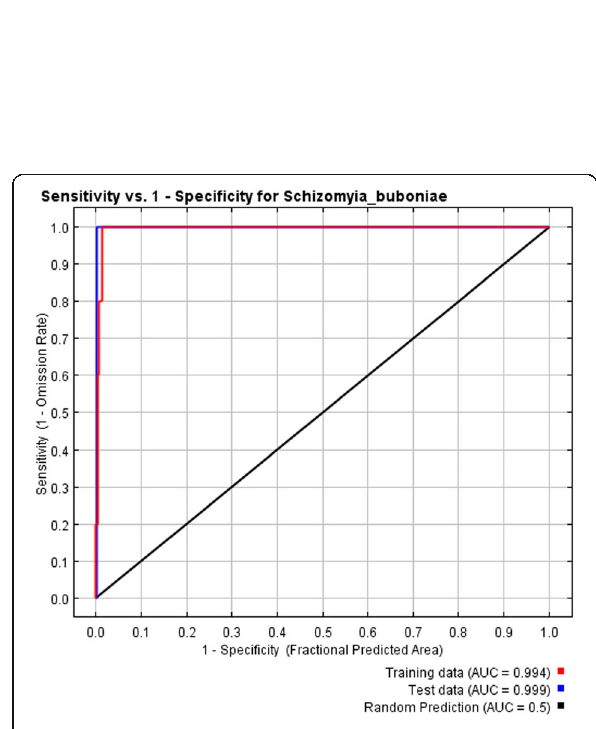
Fig. 7 The predicted distribution range of the D. tortuosa according to the MaxEnt model (map source: IESR, GIS unit, and Google Maps